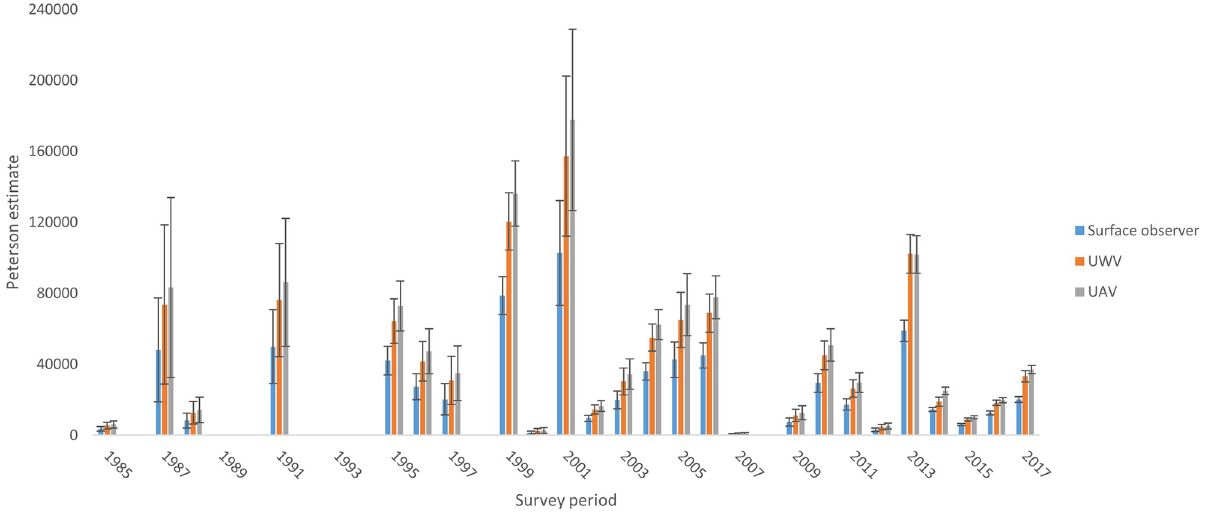
Fig 8. Historical population estimates for December sampling periods using surface observer method presented with conversion factors applied for underwater video and UAV equivalent estimates.